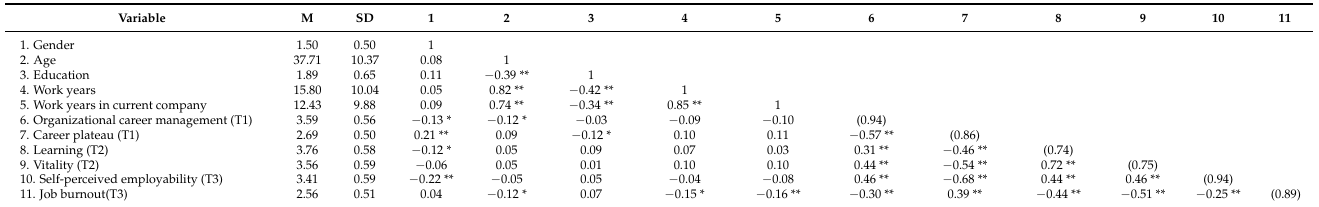
Table 2. Descriptive statistics and correlations of current study.